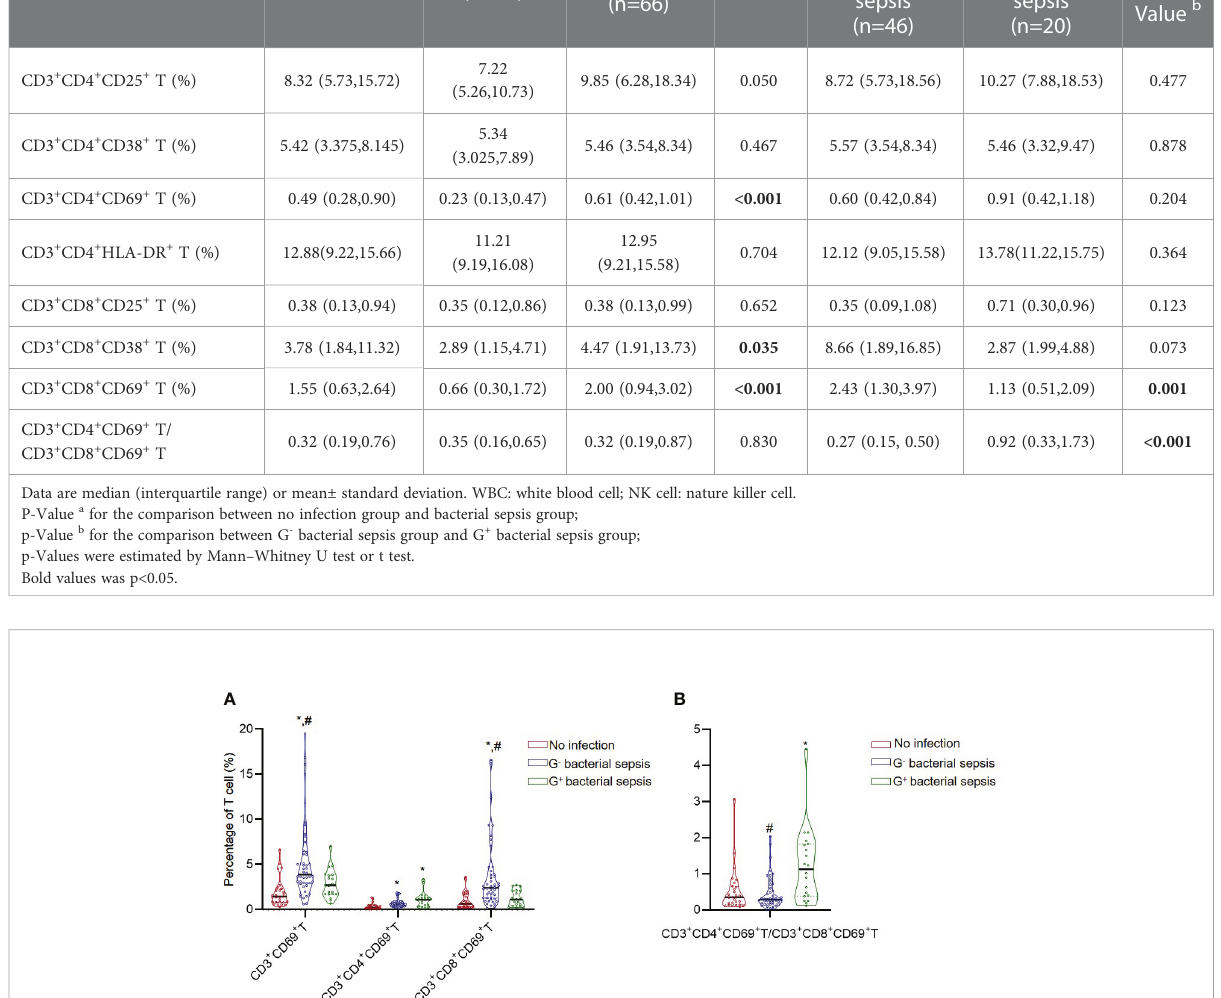
correlated with CD3 + CD69 + T(%) and CD3 + CD8 + CD69 + T(%) and positively correlated with CD3 + CD4 + CD69 + T/ CD3 + CD8 + CD69 + T, in bacterial sepsis group (n=66) (Supplementary Figure S4B) and G - sepsis (n=46) (Supplementary Figure S4C), but not in G + sepsis group (n=20) (Supplementary Figure S4D). The analysis of